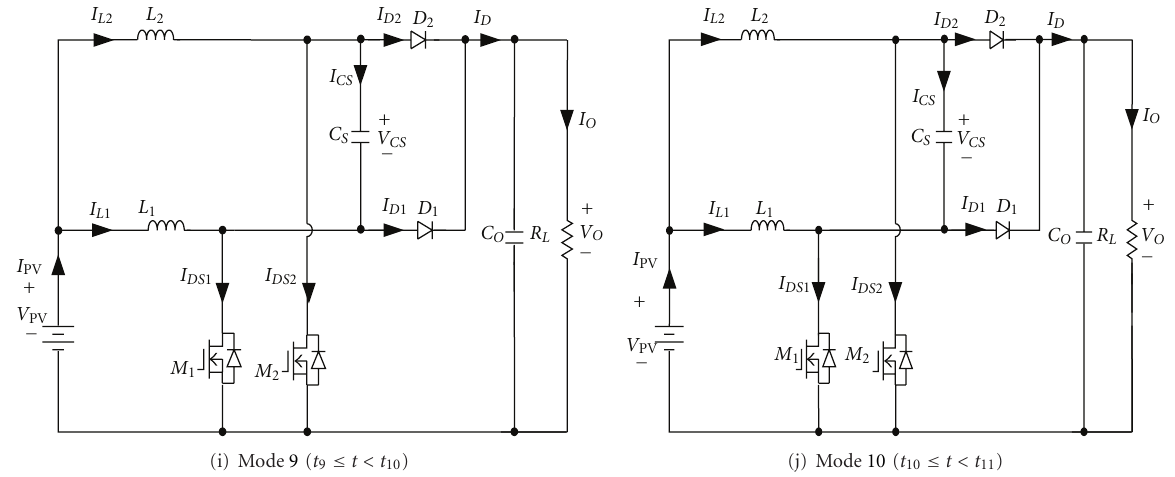
Figure 12: Operational modes of the proposed battery charger over one switching